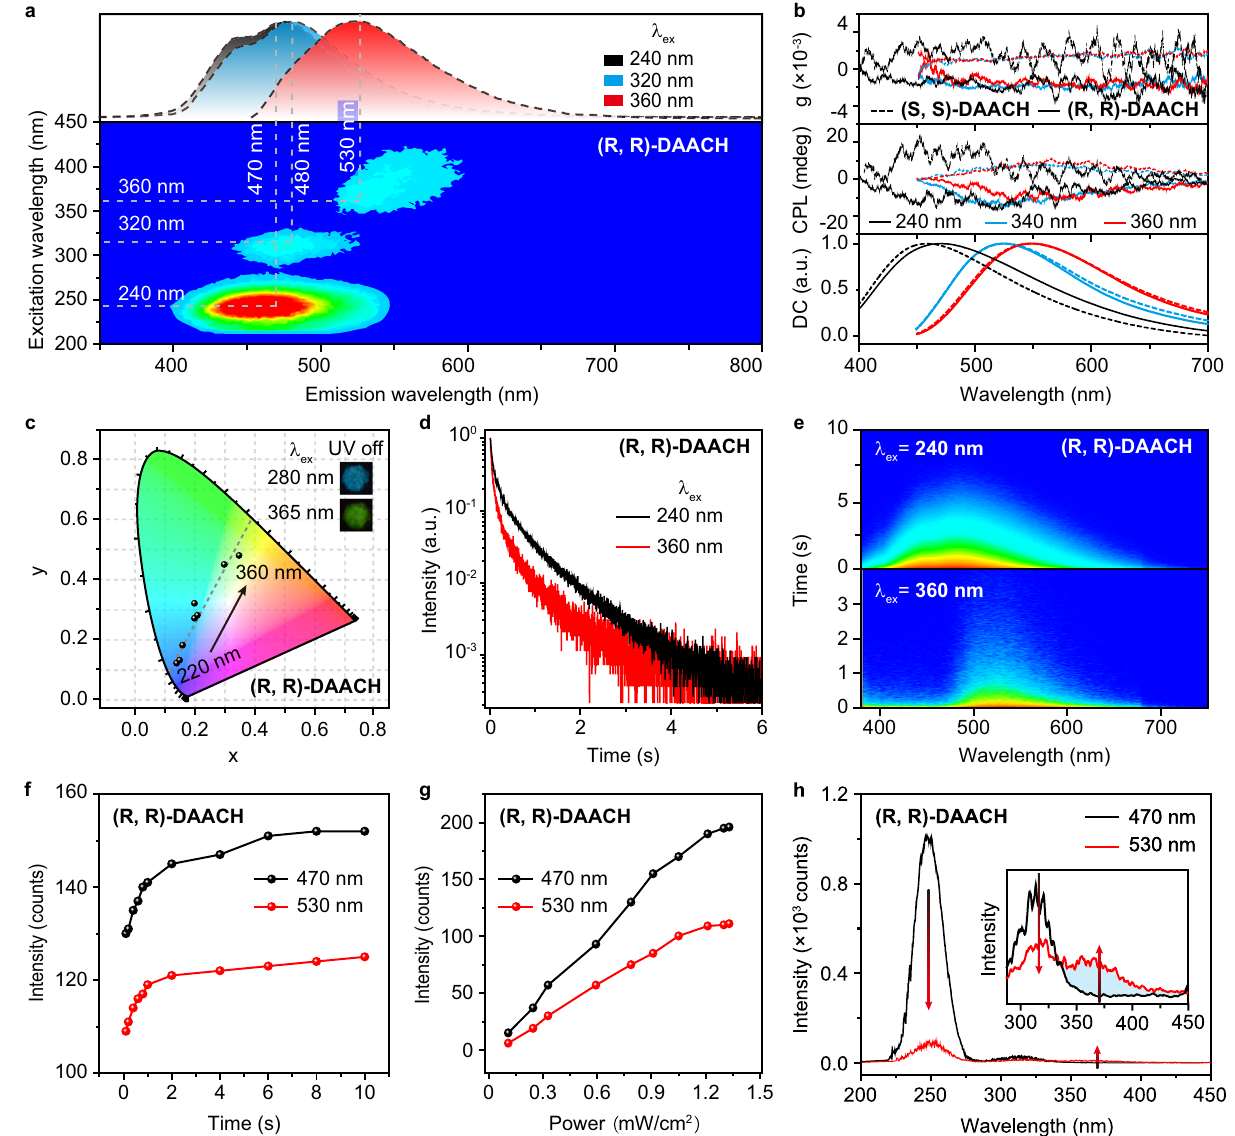
Fig. 2 Photophysical properties of the single-component color-tunable CPOA materials under ambient conditions. a Excitation-phosphorescence mapping of (R, R)-DAACH powder. The upper panel shows the CPOA spectra of (R, R)-DAACH powder under excitation by 240, 320, and 360 nm, respectively. b CPL properties of (R, R)-DAACH and (S, S)-DAACH powders under excitation by 240, 340, and 360 nm, respectively. c CIE coordinates variations of color-tunable CPOA spectra of (R, R)-DAACH powder upon excitation by a different wavelength ranging from 220 to 360 nm with a step of 20 nm. The insets exhibit the CPOA photographs of (R, R)-DAACH powder taken after turning off 280 and 365 nm excitation light, respectively. d Decay pro fi les of CPOA emission of (R, R)-DAACH powder upon excitation by 240 and 360 nm, respectively. e Transient emission decay images of (R, R)- DAACH powder following excitation by 240 (top) and 360 nm (bottom), respectively. f , g CPOA intensity changes of (R, R)-DAACH powder at 470 and 530 nm as a function of irradiation time ( f ) and intensity ( g ) upon excitation by 240 (black line) and 360 nm (red line), respectively. h Excitation spectra of (R, R)-DAACH powder by monitoring CPOA peaks of 470 and 530 nm,